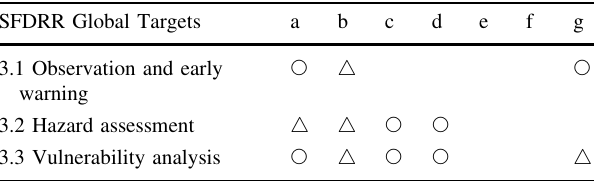
Table 1 Tsunami engineering with respect to hazards and vulnera- bilities and its contribution to the Sendai Framework global targets SFDRR Global